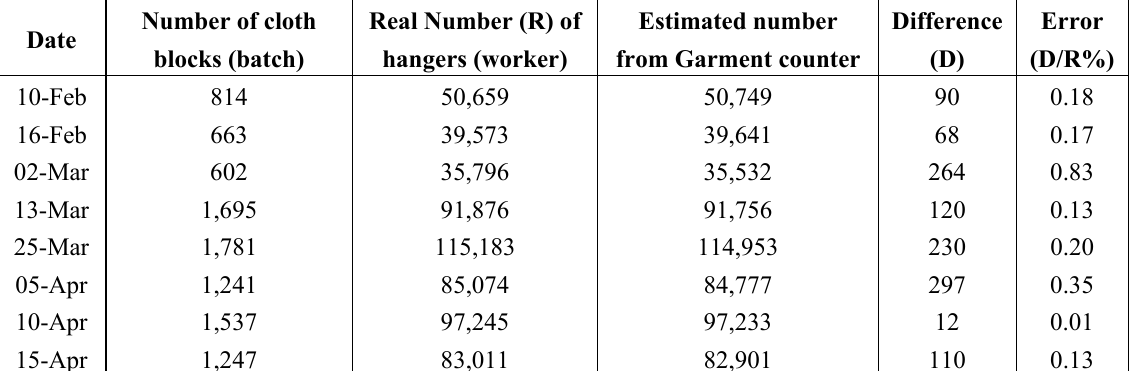
Table 1. Real test performed in continuous chain warehouse. Results from selected days.